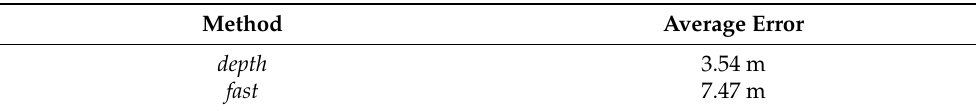
Table 3. Evaluation of the two location estimation methods.